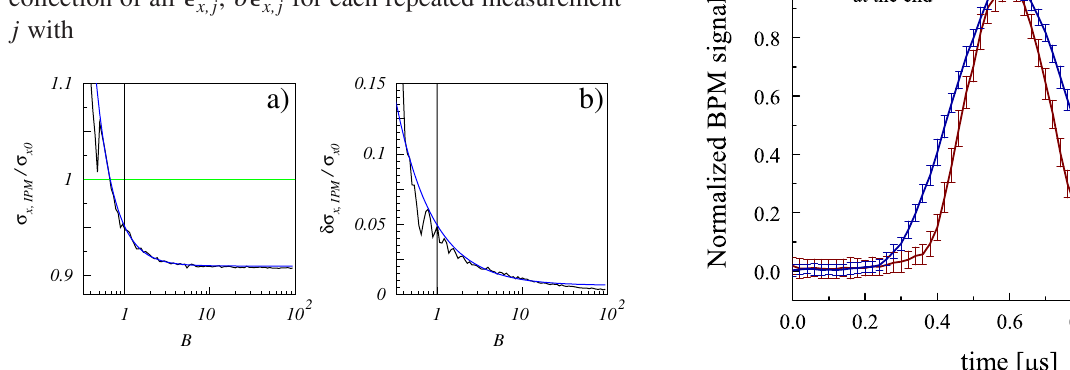
FIG. 24. Study of the systematic and random error for (cid:11) c ¼ . (a) Systematic shift of the rms size 0 : 1 , and (cid:2)N i ¼ 0 : 02 (cid:2)N i; FIG. 25. Example of average longitudinal beam profile ob- max of a Gaussian distribution. (b) The rms error of the rms size. Here tained from 30 consecutive profiles for the measurement at Q x ¼ with h ~ x i and (cid:2)(cid:4) x; with (cid:2) ~ x we identified (cid:4) x; 4 : 3365 with the bunched beam at high intensity. IPM IPM